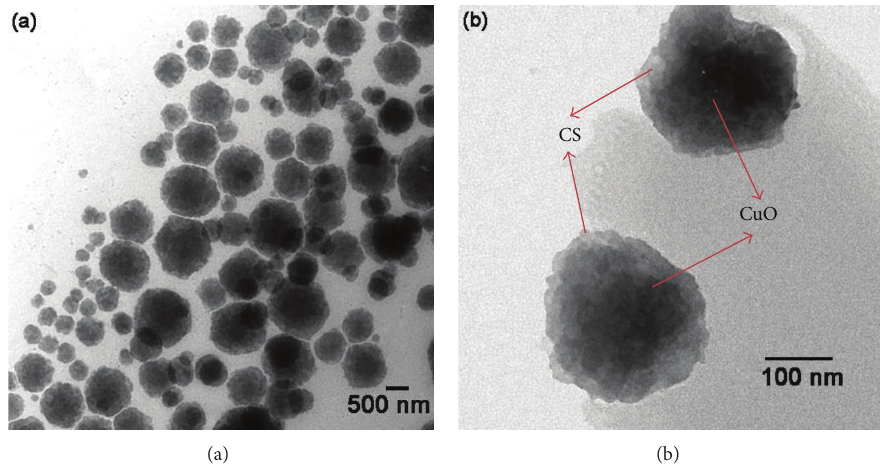
Figure 5: TEM images of CS-CuO hybrid (a) long view and (b) close